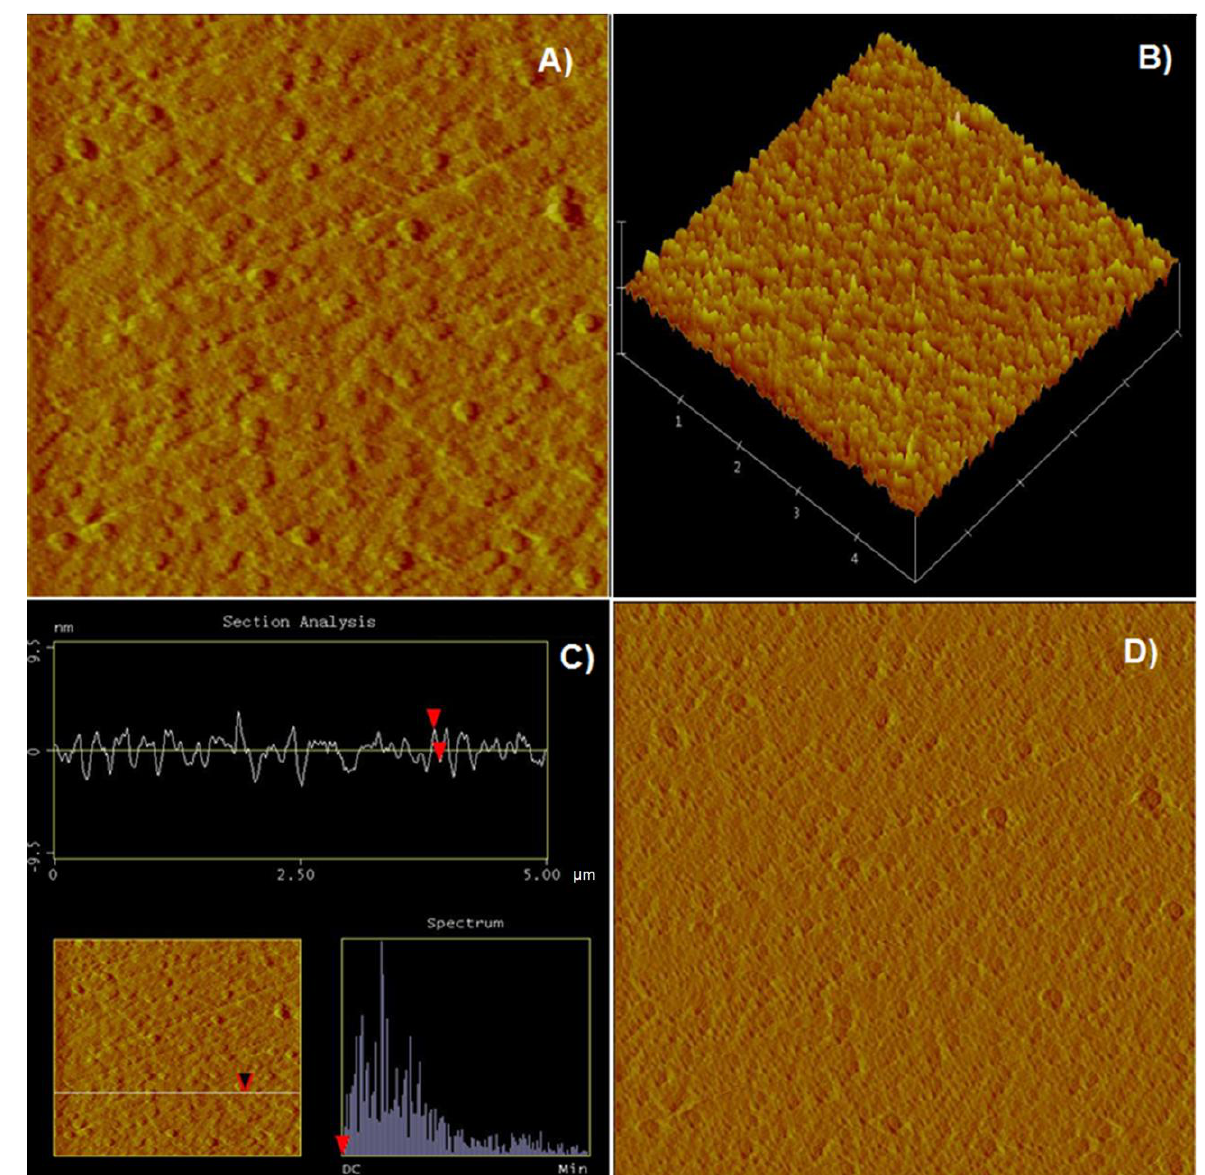
Figure 10. AFM images of a bornite surface soaked in the 1 × 10 − 4 M PAX solution at pH 6 for 10 min. ( A ) The 5 µm × 5 µm height image with a data scale of 20 nm, ( B ) the 3D image, ( C ) the section analysis (the red arrows indicate the top and the bottom of an average asperity) and ( D ) the deflection image with a data scale of 10 nm.